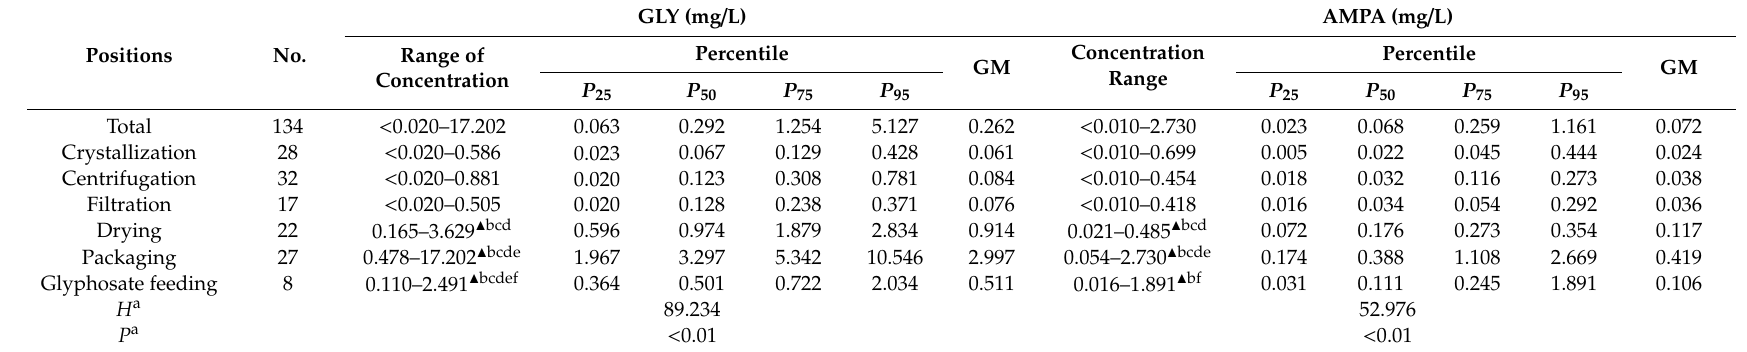
Table 3. Concentrations and descriptive statistics for urinary GLY and AMPA in